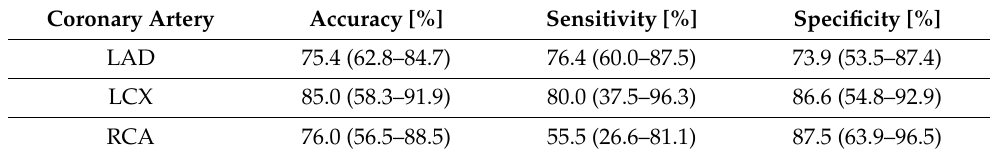
Table 7. Diagnostic performance and 95% CI of the model for the three main coronary arteries.